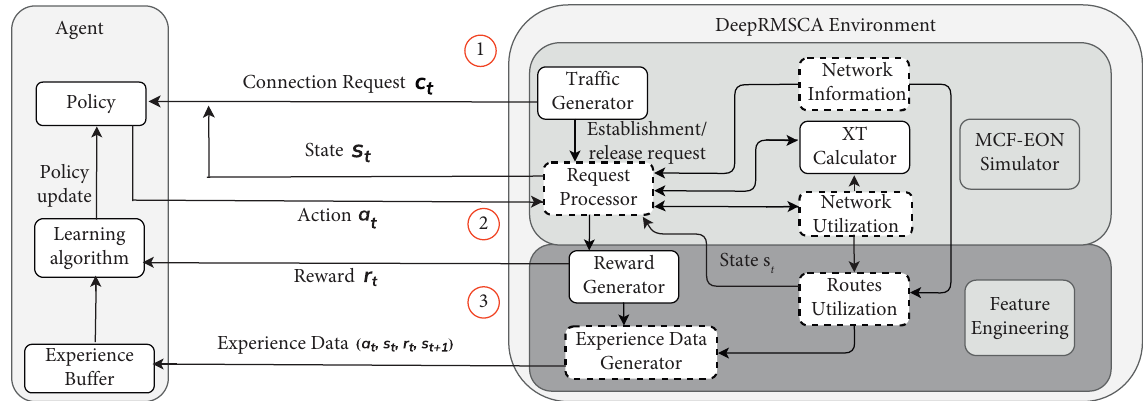
Figure 1: Interaction between a DRL agent and the MCF-EON environment developed: